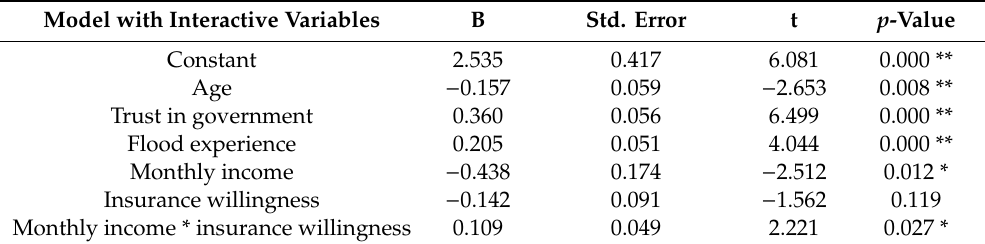
Table 6. Coefficients of Model with interactive variables. Table 6. Coe ffi cients of Model with interactive variables.